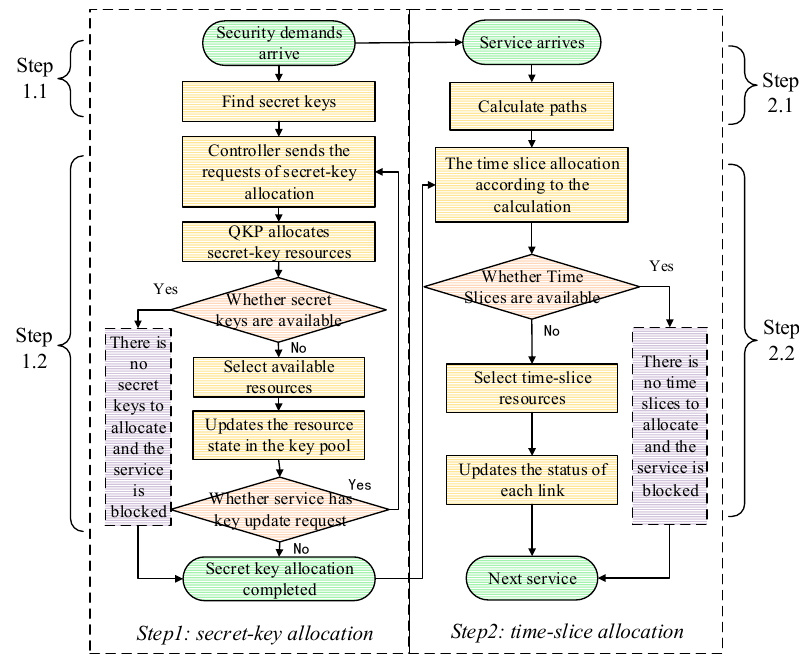
Figure 5. The flowchart for routing and resources allocation of secret-key provisioning services.